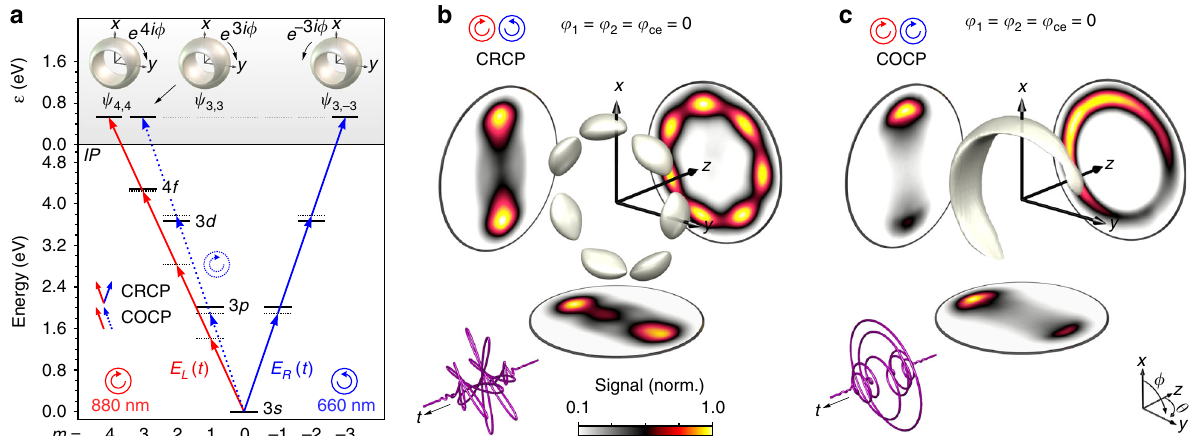
Fig. 3 Reconstructed 3D PMDs from bichromatic MPI with (3 ω :4 ω ) BiCEPS pulses. a Excitation scheme of Na atoms interacting with (3 ω :4 ω ) CRCP (red and blue solid arrows) and COCP (red solid and blue dashed arrows) fi elds. b The reconstructed FEWP from bichromatic MPI with CRCP fi elds exhibits sevenfold rotational symmetry. c The FEWP from MPI with COCP fi elds is asymmetric and localized in one-half of the polarization plane. Both results exemplify our general scheme to create odd-numbered rotational symmetric and asymmetric FEWPs